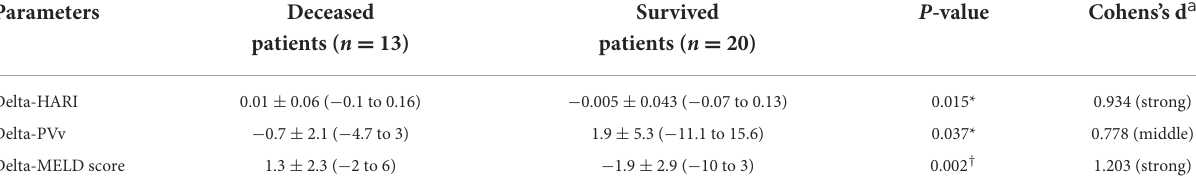
TABLE 3B Differences in perfusion parameters over time predicting